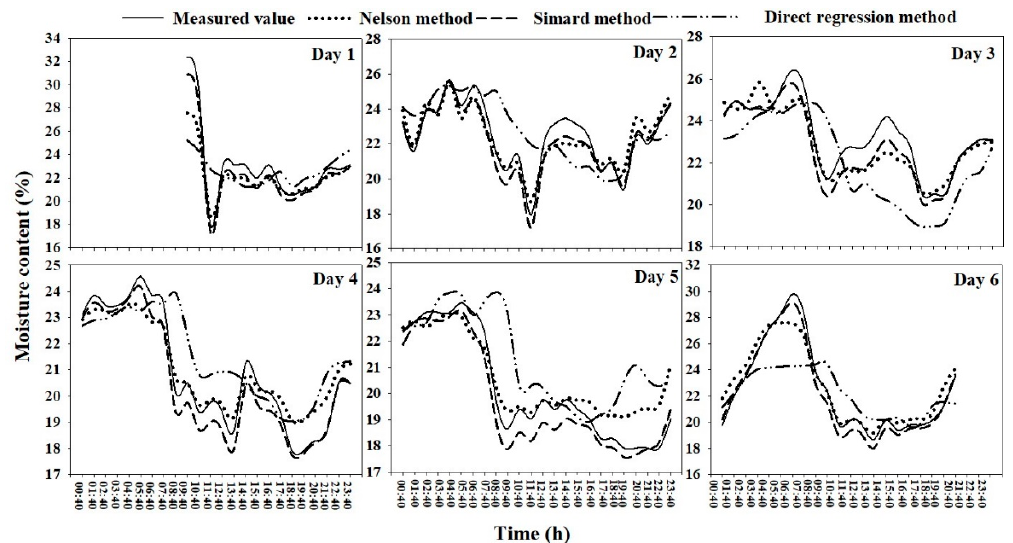
Figure 5. Measured and predicted values of the diurnal variation in litter moisture content of Mongolian oak.